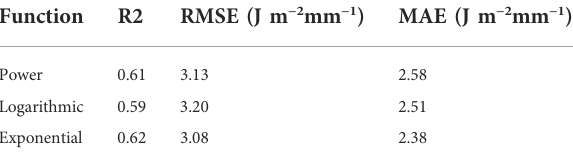
TABLE 4 Statistical analysis of the relationship between KE con andI r .